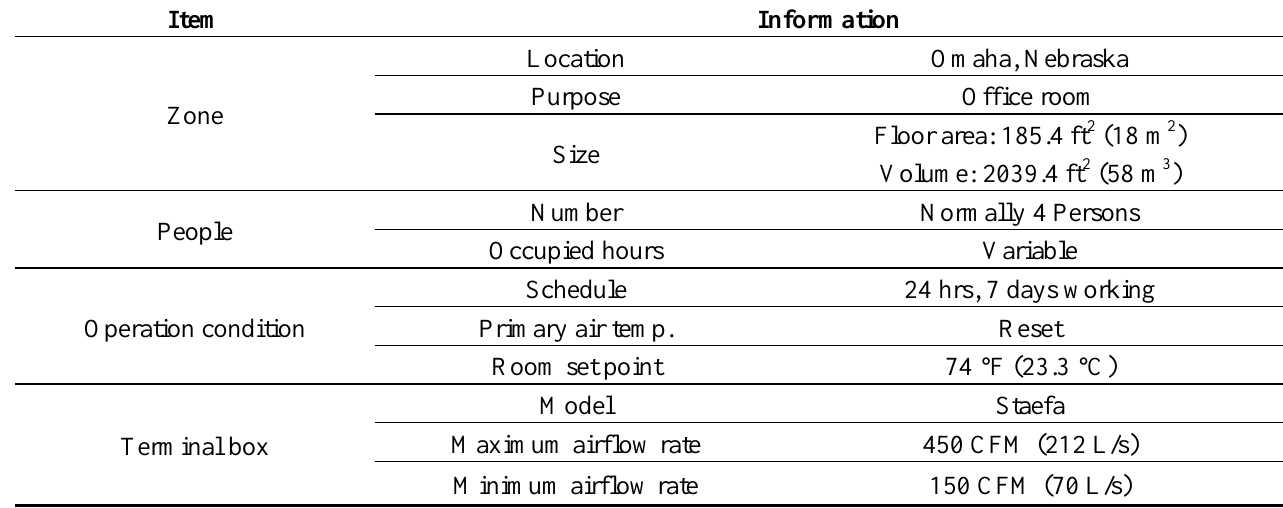
Table 5. Test room